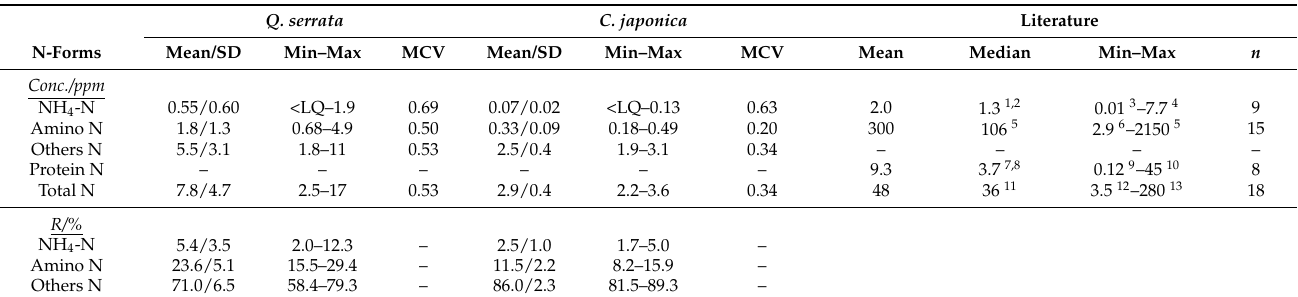
Table 4. Concentrations of N compounds in the xylem sap obtained in Experiment 1 and those reported in the